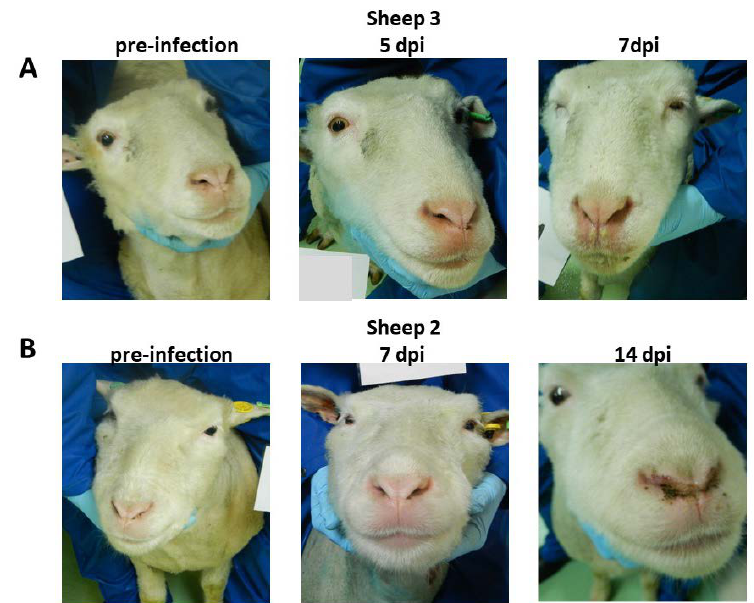
Figure 4. Clinical manifestation of BTV co-infection in Dorset Poll sheep. All four sheep developed typical clinical signs indicative of BTV infection, such as reddening of the eyes and mucosal membranes, facial edema, nasal discharge, and salivation. However, clinical progression was quicker and more pronounced in sheep 1 and 3 (e.g., Panel A , sheep 3) and both sheep were euthanized at 7 dpi on reaching the humane endpoints of the study protocol. Sheep 2 and 4 developed moderate clinical BT (e.g., panel B sheep 2) and developed more chronic disease features, such as ulcers and petechial bleeding of the nostrils, later in infection (12–16 dpi).